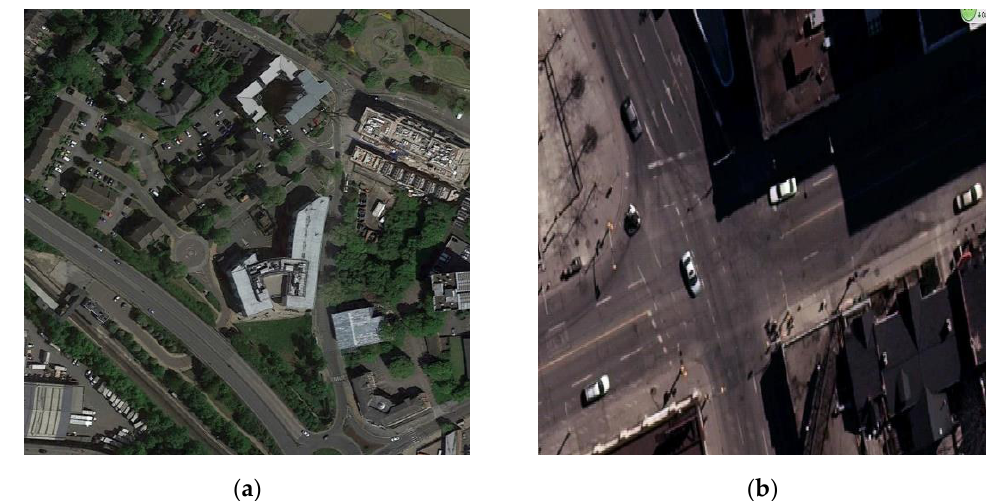
Figure 1. The vehicles in optical remote sensing imagery. Vehicles in ( a ) are generally below 10 pixels, and in ( b ) are obscured by shadows. Image in ( a ) is from the Dior dataset, and ( b ) from the HRRSD dataset.